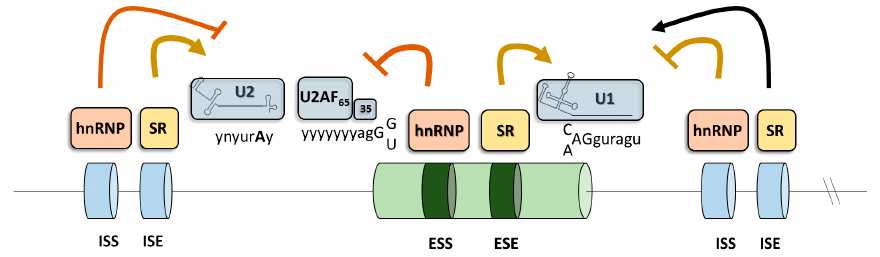
Figure 4. Elements regulating the splicing of pre-messenger RNA (mRNA). Major regulatory elements of pre-mRNA splicing, namely donor / acceptor splice sites and polypyrimidine tract, are shown with the corresponding trans-acting factors (U1, U2 snRNPs and U2AF 65 - 35 ). The Exonic Splicing Enhancer (ESE), Silencer (ESS), Intron Splicing Enhancer (ISE) or Intron Splicing Silencer (ISS) sequence(s) positively or negatively contribute to exon recognition through interaction with serine–arginine-rich (SR) proteins and heterogeneous ribonuclear particles (hnRNPs),